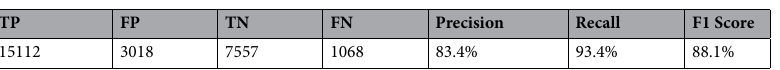
Table 5. The result of IP link classification algorithm on the verification set TeliaSonera-1.